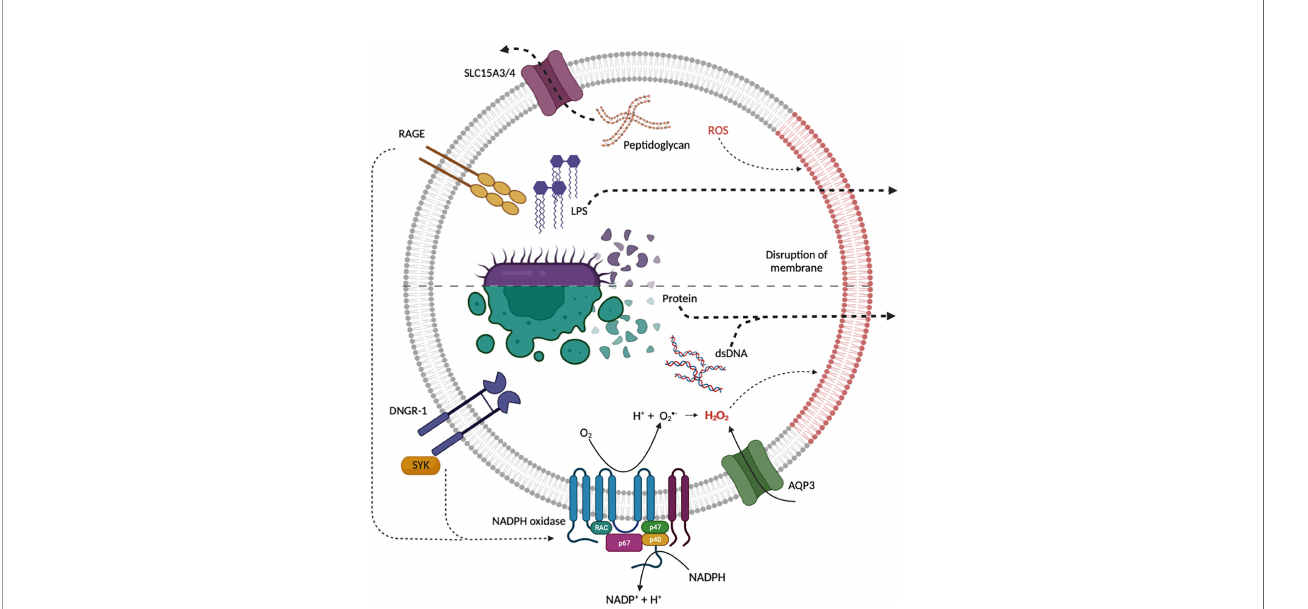
FIGURE 1 | Current proposed mechanisms for the endosomal escape of diverse macromolecular “ danger ” signals from endocytic organelles. Internalized bacteria can release peptidoglycan, LPS and bacterial protein which may gain access to the cytosol through transporters or induced membrane destabilization. Both RAGE and DNGR-1 induce NADPH oxidase ROS production, triggering ROS mediated membrane damage and the release of protein, dsDNA and LPS. NADPH oxidase and AQP3 may be recruited to endocytic organelles to induce ROS-dependent membrane damage and lipid peroxidation. Red lipids indicate disruption of endosomal membrane by ROS. Created with